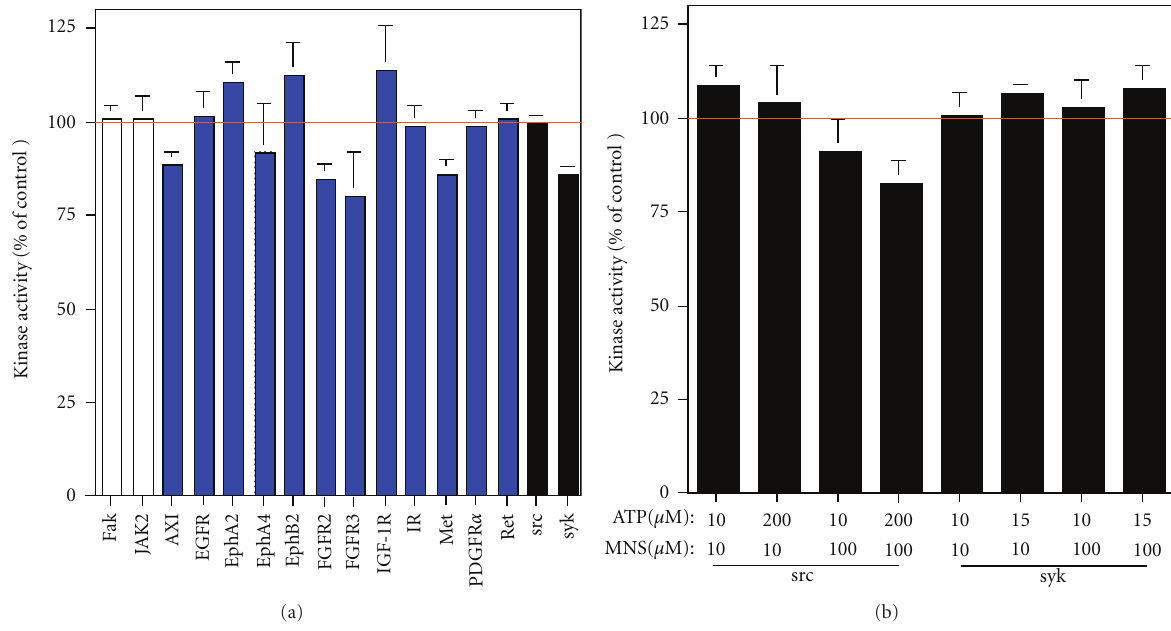
Figure 9: MNS does not inhibit activity of any of the 16 tyrosine kinases that were tested, including syk and src. In panel (a), the e ff ect of 10 μ M MNS was examined in the presence of the concentration of ATP that approximates the Km for the individual kinase. In panel (b), the e ff ect of 10 or 100 μ M MNS was examined in the presence of 10 μ M ATP or the concentration of ATP that approximates the Km for src or syk. All assays were performed in either triplicate or